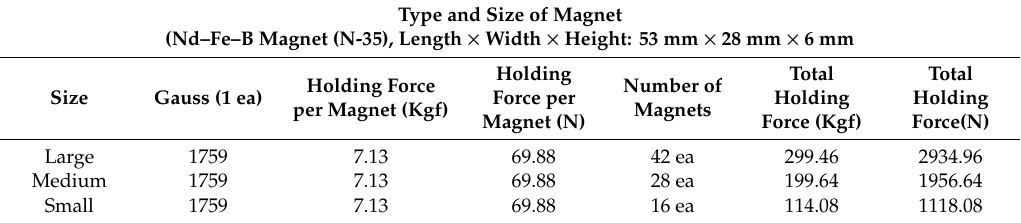
Table 3. Results of F D calculation. Table 4. Magnetic holding force (N) [42].